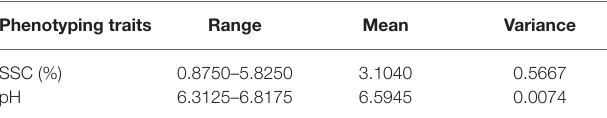
TABLE 1 | Reference measurement of SSC and pH of